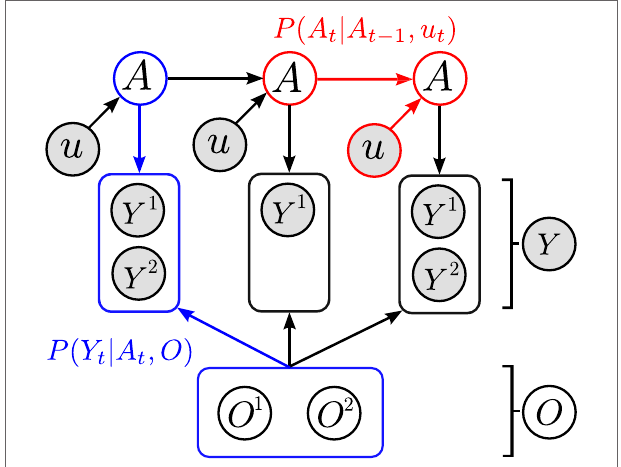
FIGURE 2 | Directed graphical model of dependencies between the agent (A) and object (O)’s estimated location. Each object, O ( i ) is associated with one sensing random variable Y ( i ) . The overall sensing random variable is Y = [ Y (1) , ... , Y ( M (cid:0) 1) ] T , where M is the total number of agent and object random variables in the filter. For readability, we have left out the time index t from A and Y . Since the objects are static, they have no temporal process associated with them thus they will never have a time subscript. The two models necessary for filtering are the motion model P ( A t | A t (cid:0) 1 , u t ) (red) and measurement model P ( Y t | A t , O )